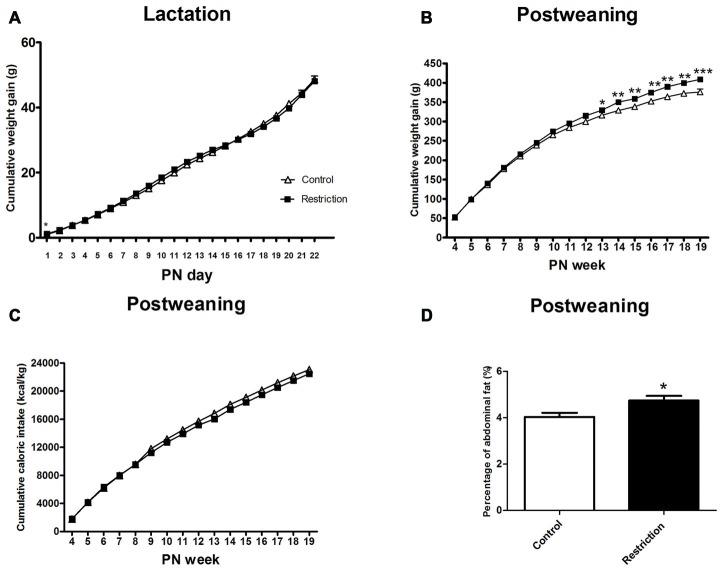
Effect of preconceptional/pregnancy restricted diet on metabolic-related parameters in male rat offspring after birth. Cumulative weight gain (g) of control group offspring (open triangles) and caloric restricted group offspring (solid squares) during lactation (A) and postweaning (B) period. Cumulative caloric intake (Kcal/kg) of control offspring (open triangles) and calorie-restricted offspring (solid squares) during postweaning period (C). Offspring adiposity, calculated as the percentage of the abdominal fat (the sum of perirenal and perigonadal fat) at 5th PN month, is shown in (D): control offspring (open bars) vs. caloric restricted offspring (solid bars). Values are expressed as mean ± SEM. *p < 0.05, **p < 0.01, ***p < 0.001.